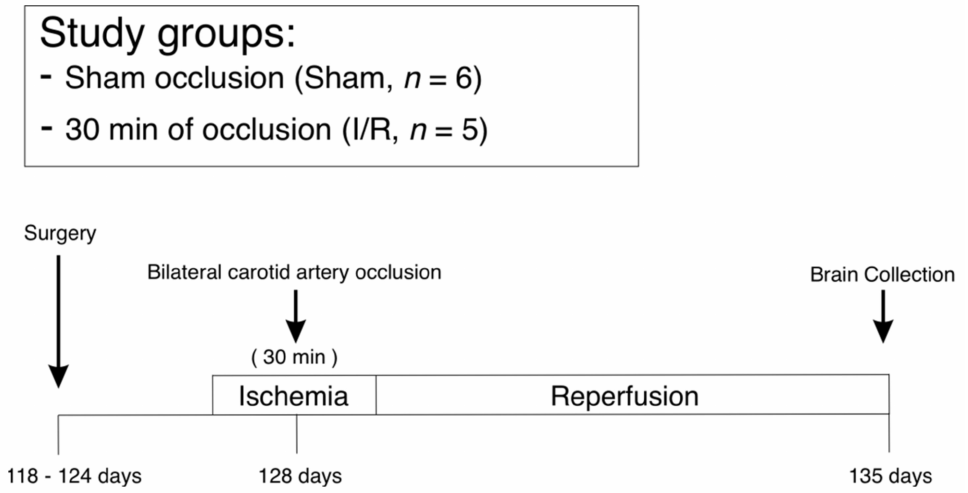
Figure 9. The study groups, animal preparation, and experimental design shown schematically. Fetal sheep at 128 days of gestation (85% of gestation) were randomly assigned to two groups: Sham-treated (Sham, n = 6), and 30 min of cerebral ischemia followed by 7 days of reperfusion (I/R, n = 5). Surgery was performed on the fetal sheep at 118–124 days of gestation. Occluders were placed bilaterally around the carotid arteries. At 128 days of gestation, reversible bilateral carotid artery occlusion was performed for 30 min to induce cerebral ischemia. Thereafter, the occluders were deflated and reperfusion continued for 7 days. In contrast, the occluders were not inflated in the sham group. After in vivo perfusion, the brain was collected at 135 days of